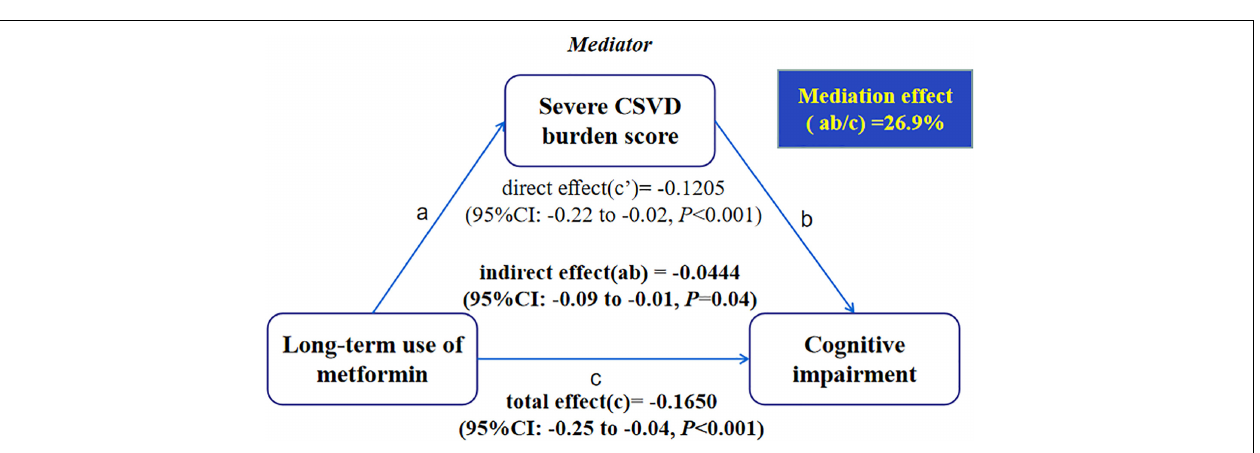
FIGURE 3 | Causal mediation analysis is shown for the presence of severe CSVD burden score as a mediator in the relation between long-term use of metformin and cognitive